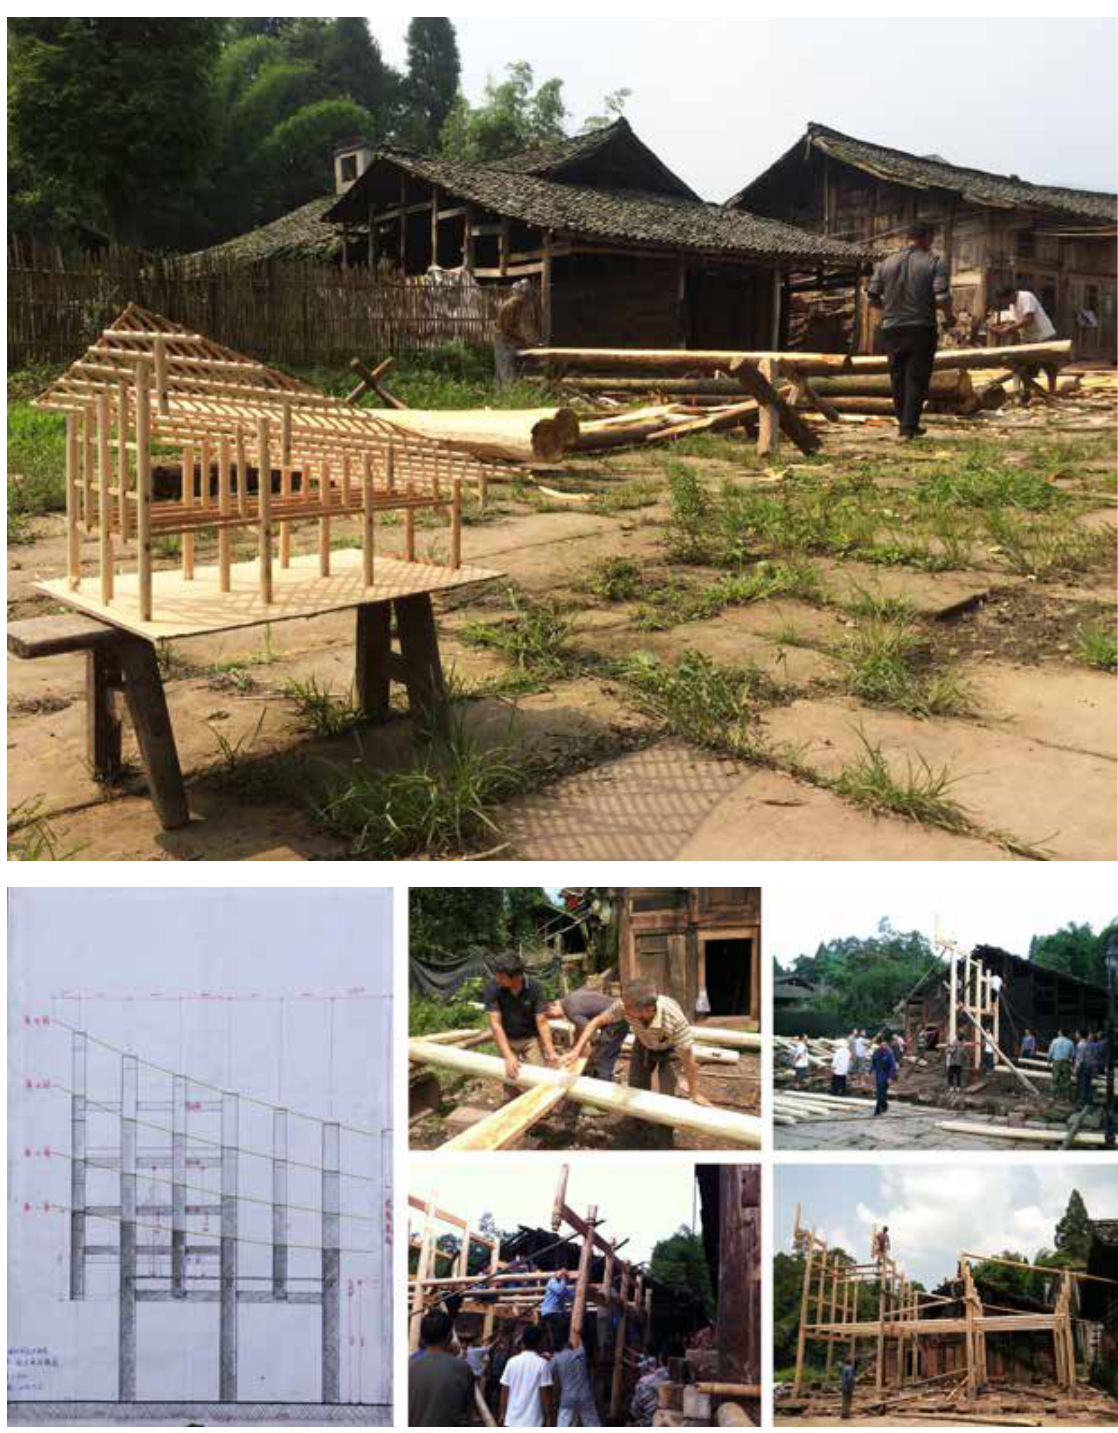
Figure 2a-e (bottom): Chuan Dou construction sequence, Miaoxia community kitchen under construction in July